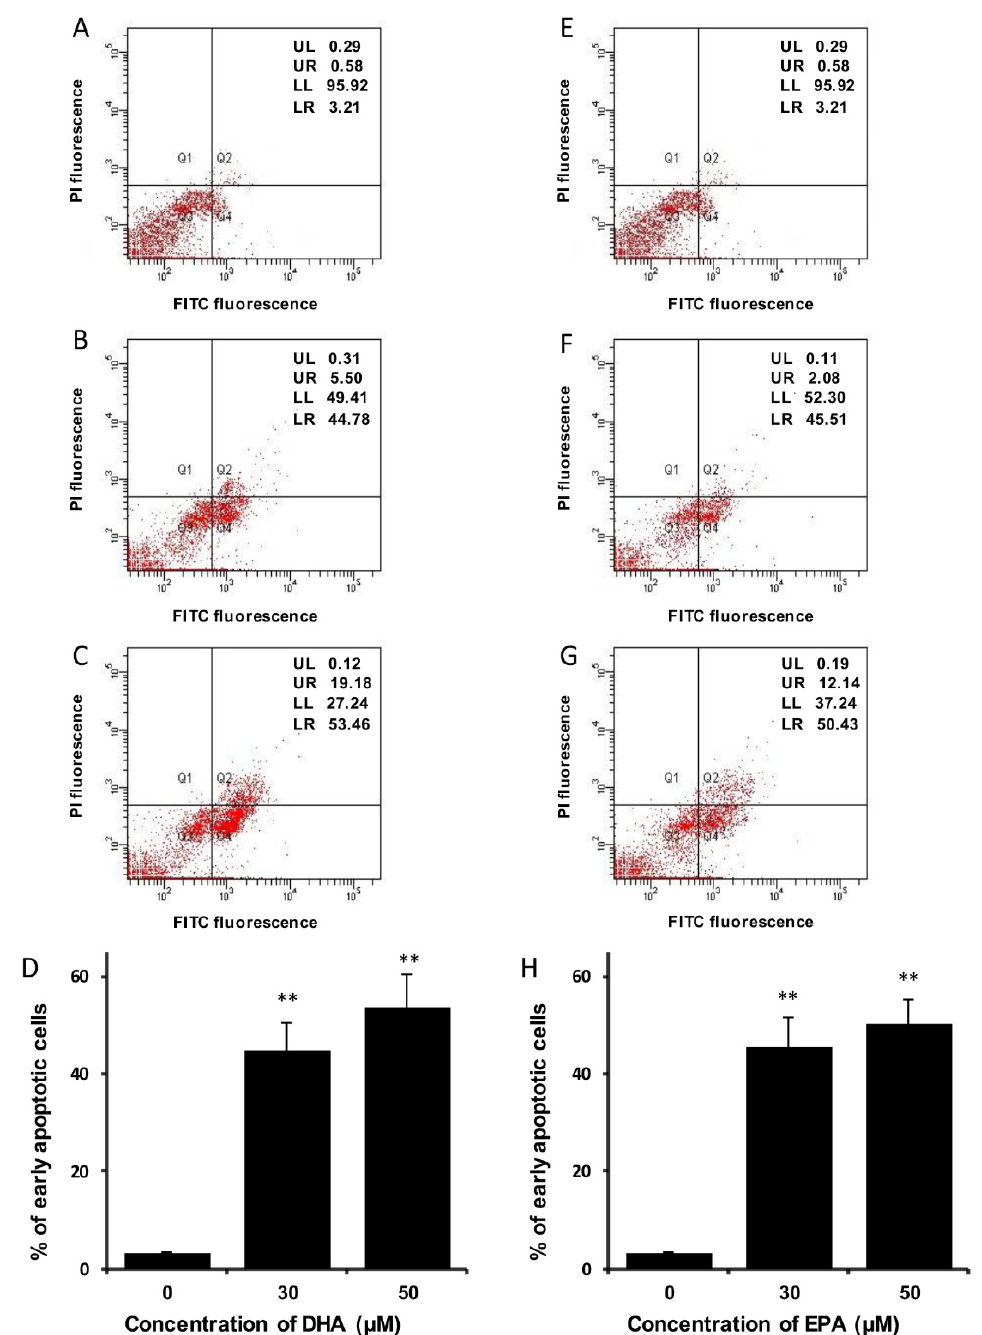
Figure 4. DHA and EPA trigger phosphatidylserine externalization in LA-N-1 cells. ( A – D ) LA-N-1 cells were incubated with ethanol control ( A ), 30 or 50 µM DHA ( B , C ) for 48 hours. ( E – H ) LA-N-1 cells were incubated with ethanol control ( E ), 30 or 50 µM or EPA ( F , G ) for 48 hours. After incubation, the cells were stained by Annexin V-GFP fusion protein and PI, and the fluorescence intensity was measured by flow cytometry. The results are quantified and expressed as mean values ± SD ( D , H ). ** p < 0.01.